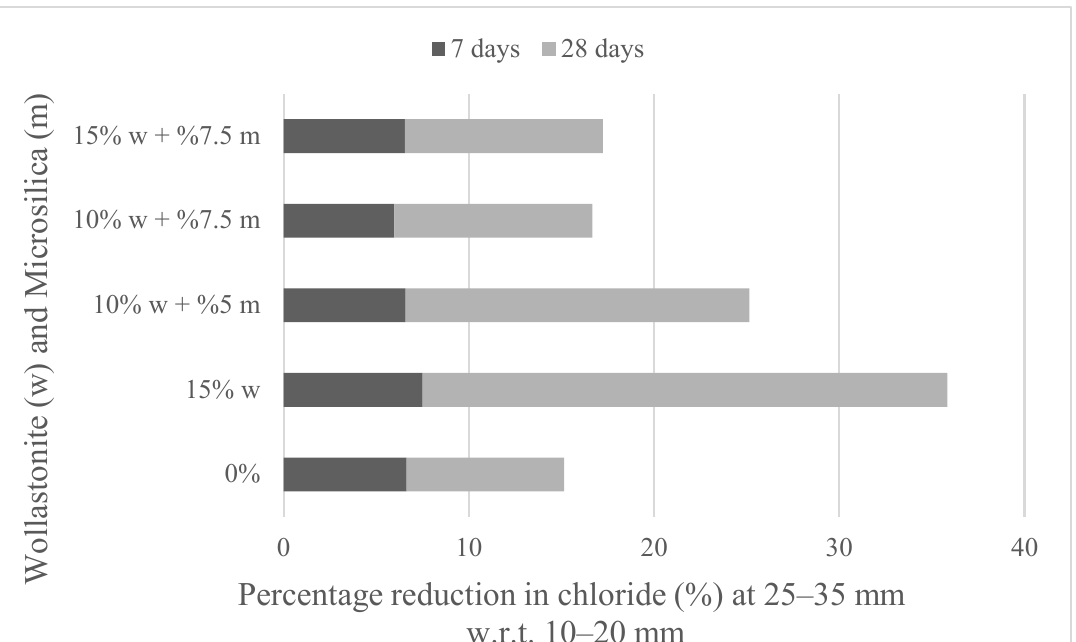
Figure 14. Percentage reduction in chloride and wollastonite–microsilica replacement based on Ref. [27].